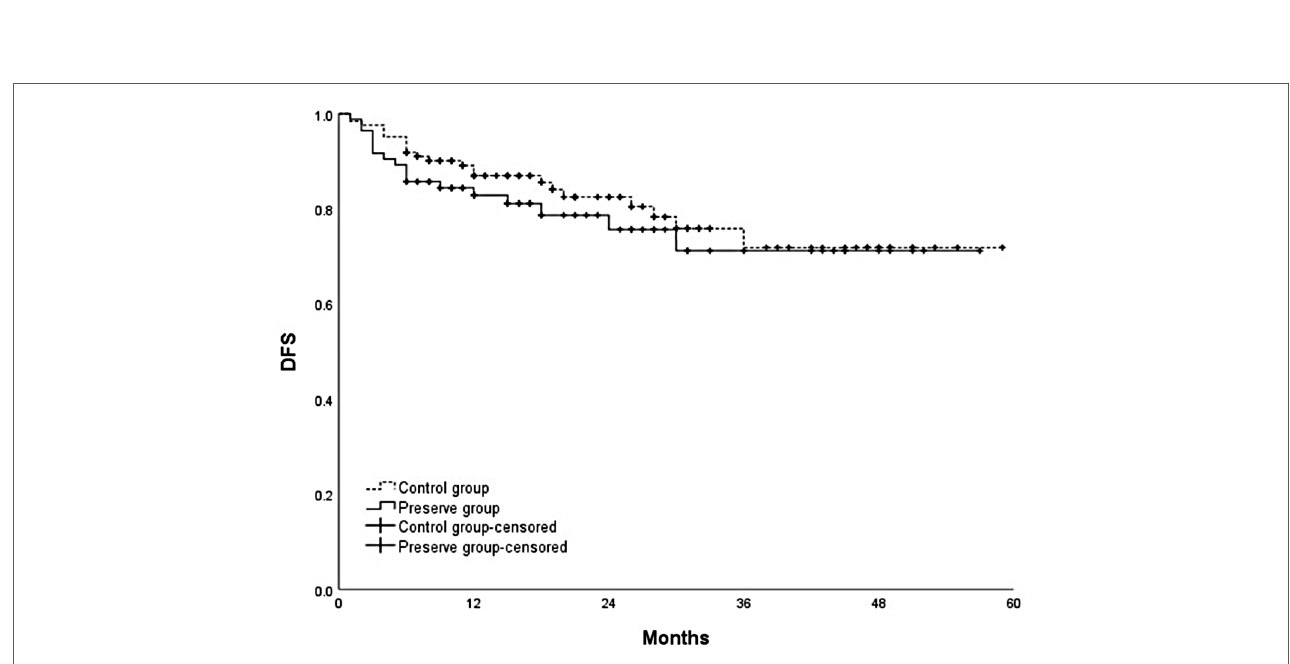
FIGURE 4 Comparison of disease-free survival between SRA preservation group and control group ( p